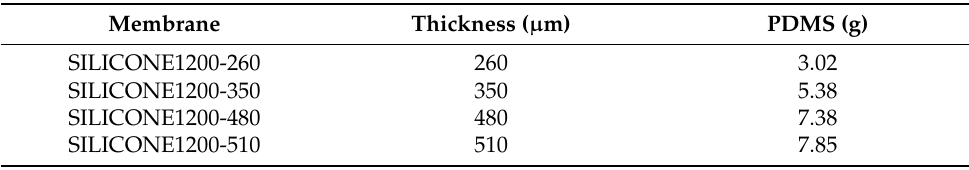
Table 3. Preparation conditions of the PDMS